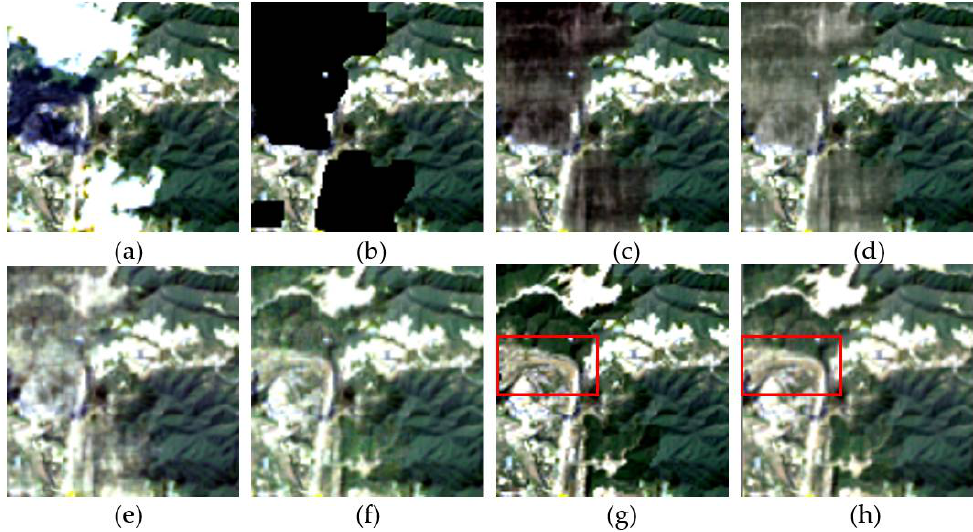
Figure 20. Enhanced detail from Figure 19a–h: ( a ) original image; ( b ) masked image; ( c – h ) recon- structed images with HaLRTC, AWTC, NL-LRTC, TVLRSD, ST-Tensor and FMTC algorithms, re- spectively. Table 7. Quantitative comparisons of six algorithms applied to dataset 7.